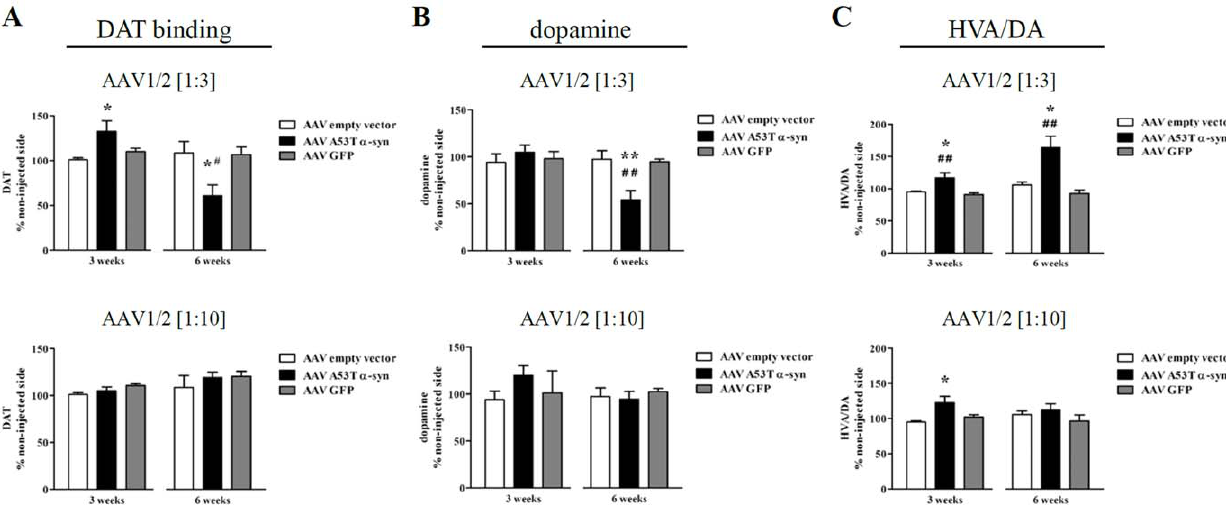
Figure 6. Striatal changes in dopamine transporter and neurochemistry following intra-nigral injection of AAV1/2 A53T a - synuclein. Three weeks post AAV1/2 A53T a -syn injection of the 1:3 dilution there was a significant rise in dopamine transporter (DAT) followed 3 weeks later by a significant reduction (A). No changes in striatal DAT was observed using the 1:10 dilution of AAV1/2 A53T a -syn at either timepoint (A). Dopamine loss was seen only in the 1:3 dilution of AAV1/2 A53T a -syn and only after 6 weeks of exposure (B). Dopamine turnover (HVA/DA) was significantly elevated in both the 1:3 and 1:10 AAV1/2 A53T a -syn conditions, 3weeks post vector injection. By 6 weeks however, DA turnover had returned to normal in the 1:10 AAV1/2 A53T a -syn group and had increased further in the 1:3 AAV1/2 A53T a -syn group (C). * , ** c.f. empty vector, P , 0.05 and 0.01, respectively; # , ## c.f. GFP, P , 0.05 and 0.01, respectively.